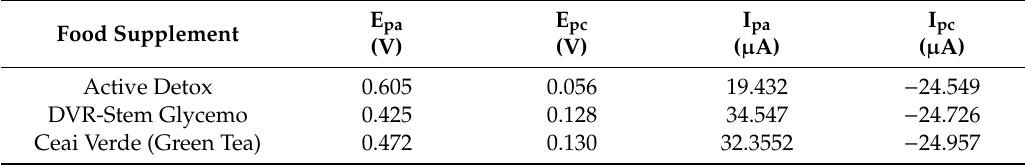
Table 7. Parameters of the cyclic voltammograms of the CNF / C-SPE immersed in the real samples. Food Supplement